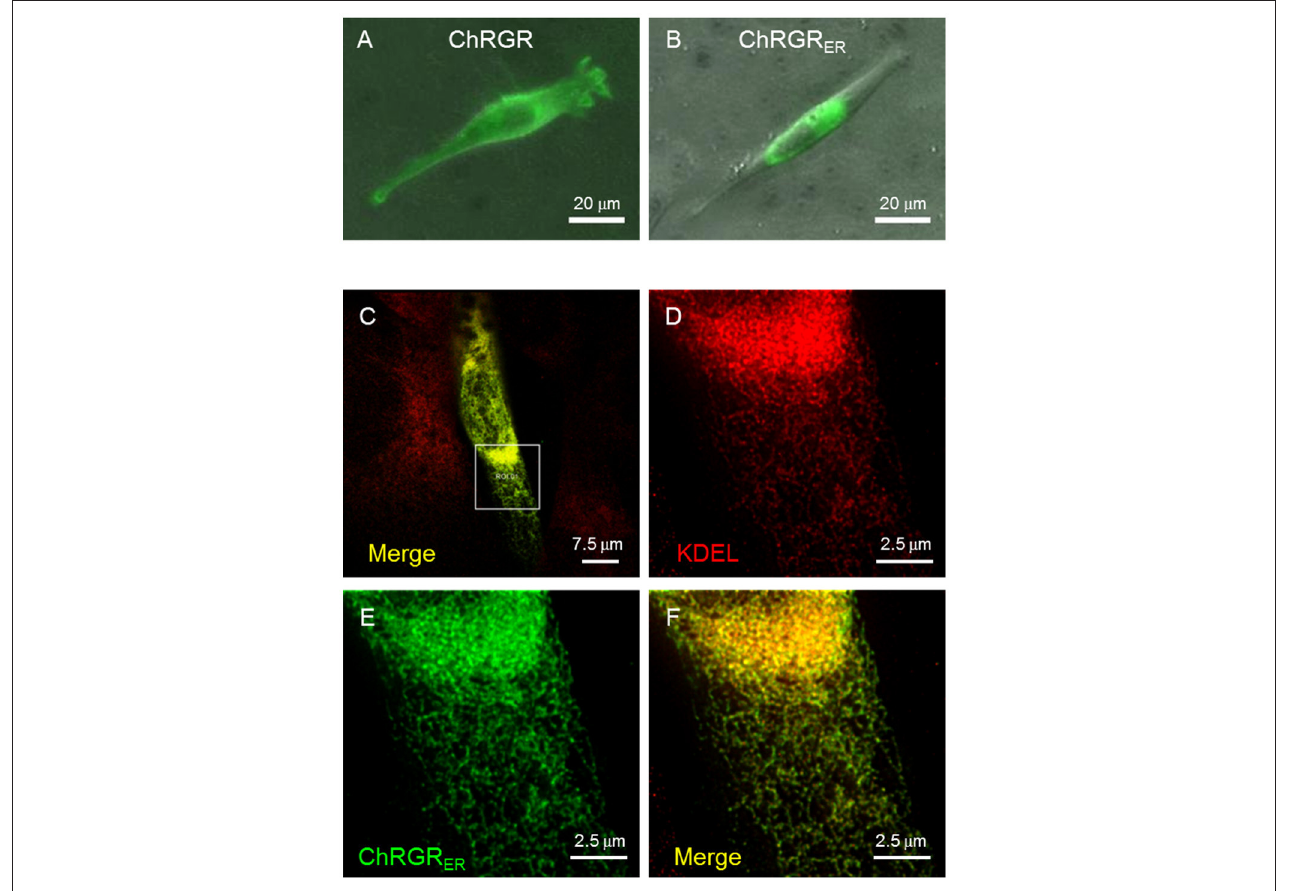
FIGURE 2 | Cellular expression of ChRGR ER . (A) Image of Venus fluorescence of a typical C2C12 cell expressing ChRGR. (B) Another typical C2C12 cell expressing ChRGR ER . (C) Merged image of super-resolution microscopy (STED) of C2C12 immunostained for Venus (green) and ER-marker KDEL (red) at low magnification. (D–F) The ROI encircled in (C) was enlarged for each color channel; KDEL ( D , red), Venus ( E , green), and the merge (F)